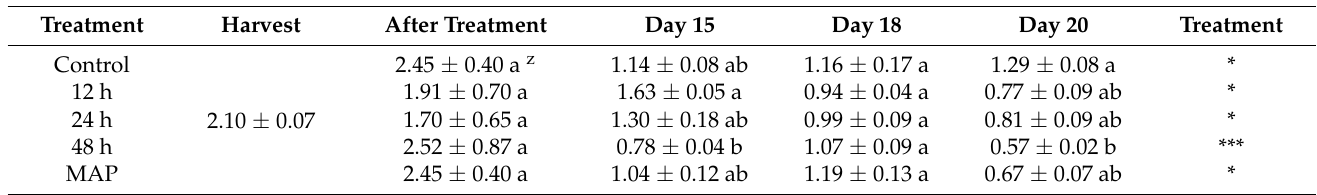
z Values are represented as the mean ± SE ( n = 4), and different alphabets within columns represent significant differences among treatments for each measuring day using Tukey’s multiple comparison test. Day 18 and Day 20 represent three and five days after cold storage, respectively. *, ***: significant at p ≤ 0.5 and 0.001. The O 2 and CO 2 content show a reversed pattern throughout the measuring time (Figure 4A,B). The 50,000 cc · m − 2 · day − 1 · atm − 1 OTR film used kept the average CO 2 content value at a maximum of 2.05 ± 0.51%. The ethylene content was at its peak on the 10th day,